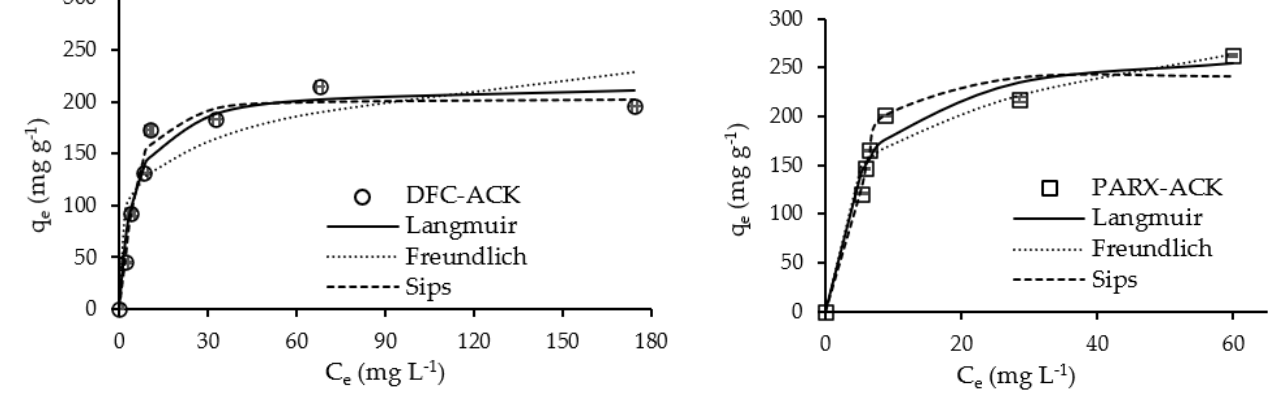
Figure 7. Adsorption equilibrium curves of DCF and PARX for ACK carbon (Adsorbent mass = 10 mg; Contact time = 4 h; Solution volume = 25 mL; Solution initial pH = 6.0 (DCF) and 5.5 (PARX)). Dots—experimental data; Lines—isotherm models’ adjustment.